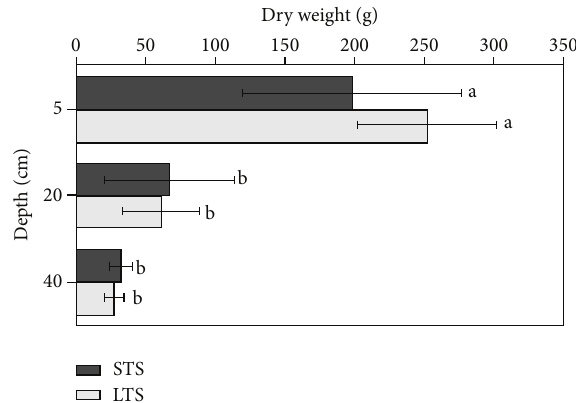
Figure 8: Mean and standard deviation of the root weight, at 5, 20, and 40 cm depth. ∗ Nonparametric analysis Mann-Whitney 𝑈 test. ∗ Different letters indicate significant difference ( 𝑃 < 0.05